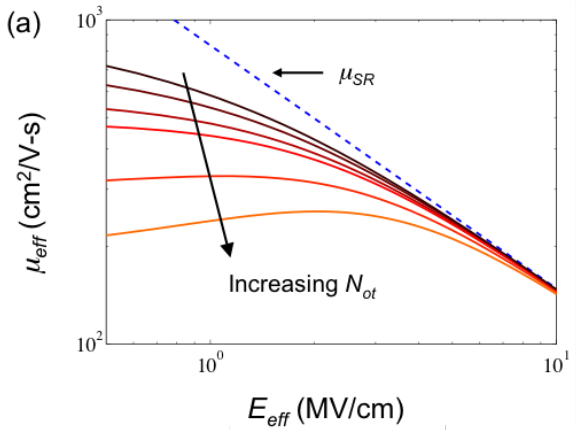
Figure 8. ( a ) Calculations of the effective electron mobility ( μ plotted as a function of the effective vertical field ( E dashed line corresponds to the short-range mobility given by Equation 7; ( b ) Comparison of μ extracted from data in Figure 5 (symbols) and model calculations (lines) including eff scatterer